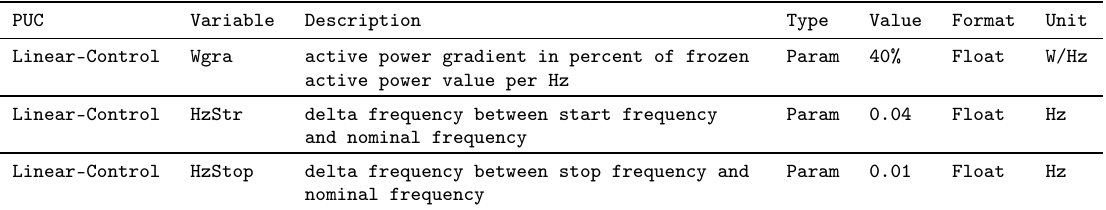
Table 14. PUC(Linear-Control) conception from